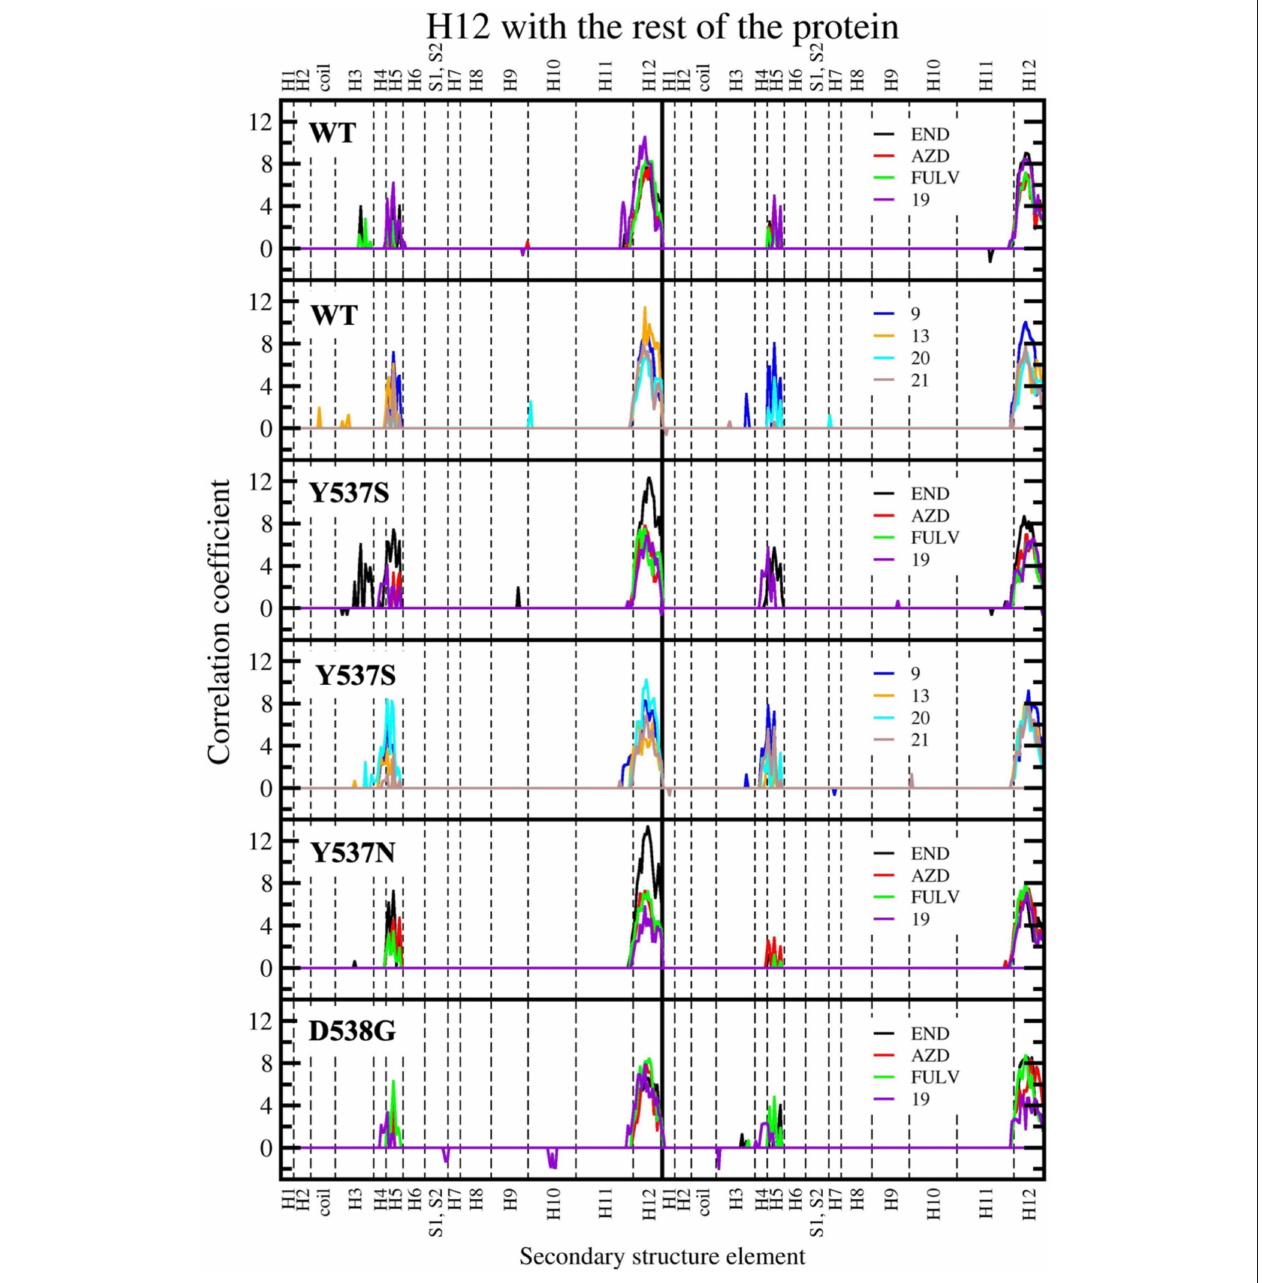
FIGURE 8 | Sum of per-residue cross-correlation coefficients. Left and right columns refer to monomers A and B, respectively. From top to bottom: WT (in complex with END, AZD, FULV, and 19 ), WT (with 9 , 13 , 20 , and 21 ), Y537S (with END, AZD, FULV, and 19 ), Y537S (with 9 , 13 , 20 , and 21 ), Y537N, and D538G (in complex with END, AZD, FULV, and 19 ). END, AZD, FULV, and compounds 9 , 13 , 19 , 20 , 21 are shown as black, red, green, blue, orange, purple, cyan, and brown lines, respectively.